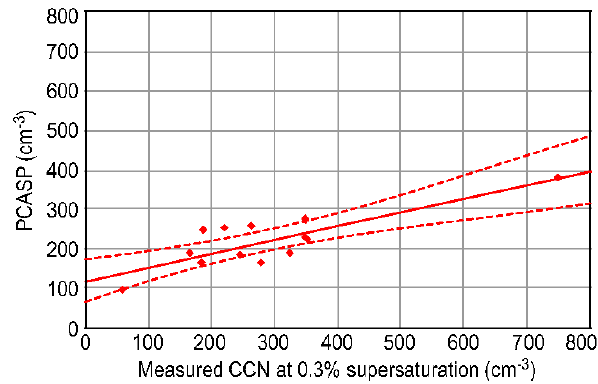
Figure 1. Regression plot of the PCASP number concentration vs the CCN number concentration active at 0.3% supersaturation for the CARMA IV study. The solid line is the best-fit line and the dashed lines are the 95% confidence limits.